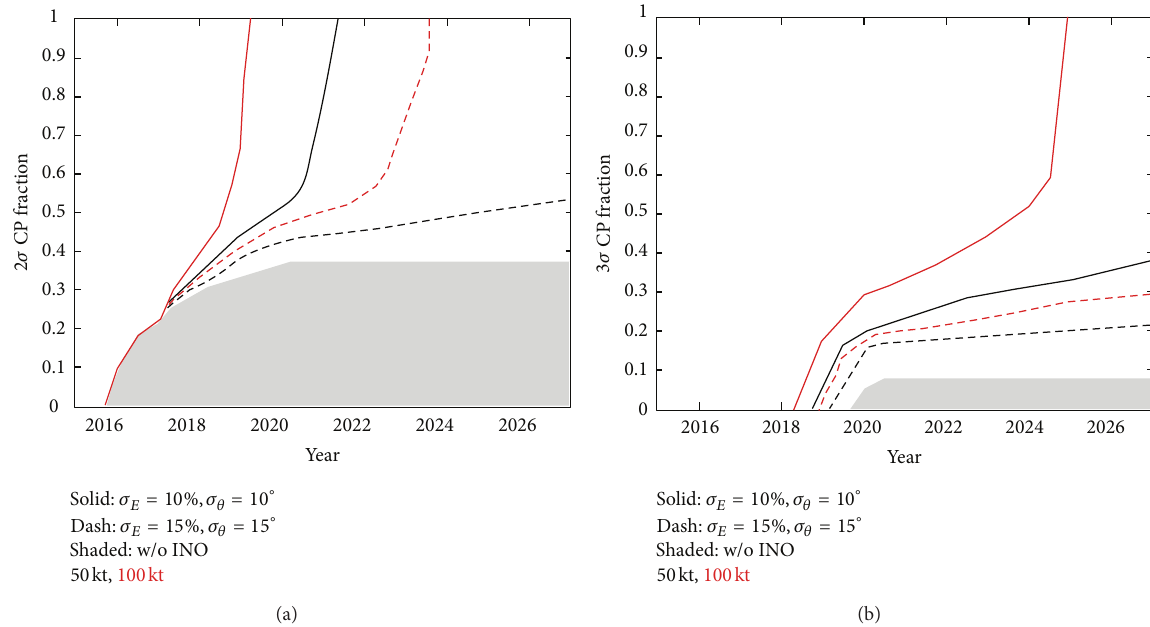
Figure 5: The time evolution of the fraction of values of the CP phase 𝛿 for which the combination of INO, NOvA, T2K, and DayaBay would be sensitive to the mass ordering at 2𝜎 (a) and 3𝜎 (b). Black (red) curves correspond to INO detector mass of 50kt (100kt) and dashed (solid) curves correspond to the low (high) resolution scenario; see text. The shaded area is the corresponding result without atmospheric data from INO. The true value of sin 2 2𝜃 13 has been assumed to be 0.09 . Figures are based on the results of [60, 61].